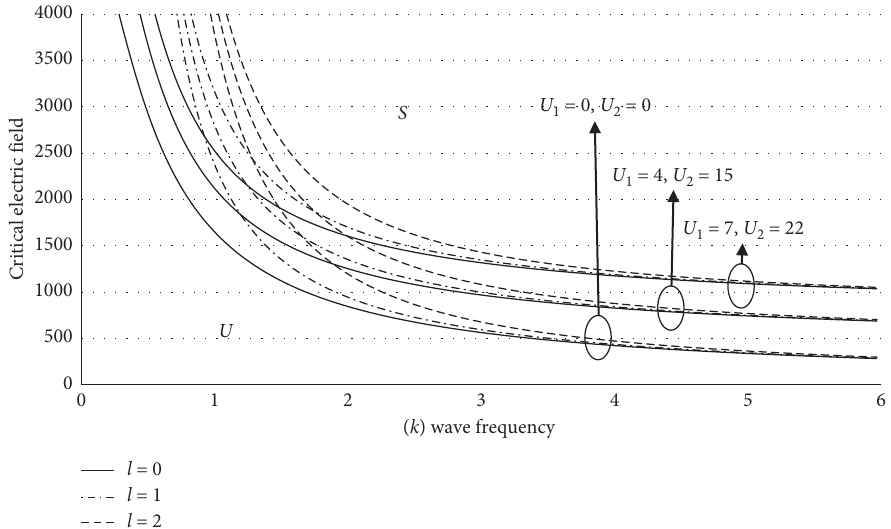
Figure 6: Variation of E 2